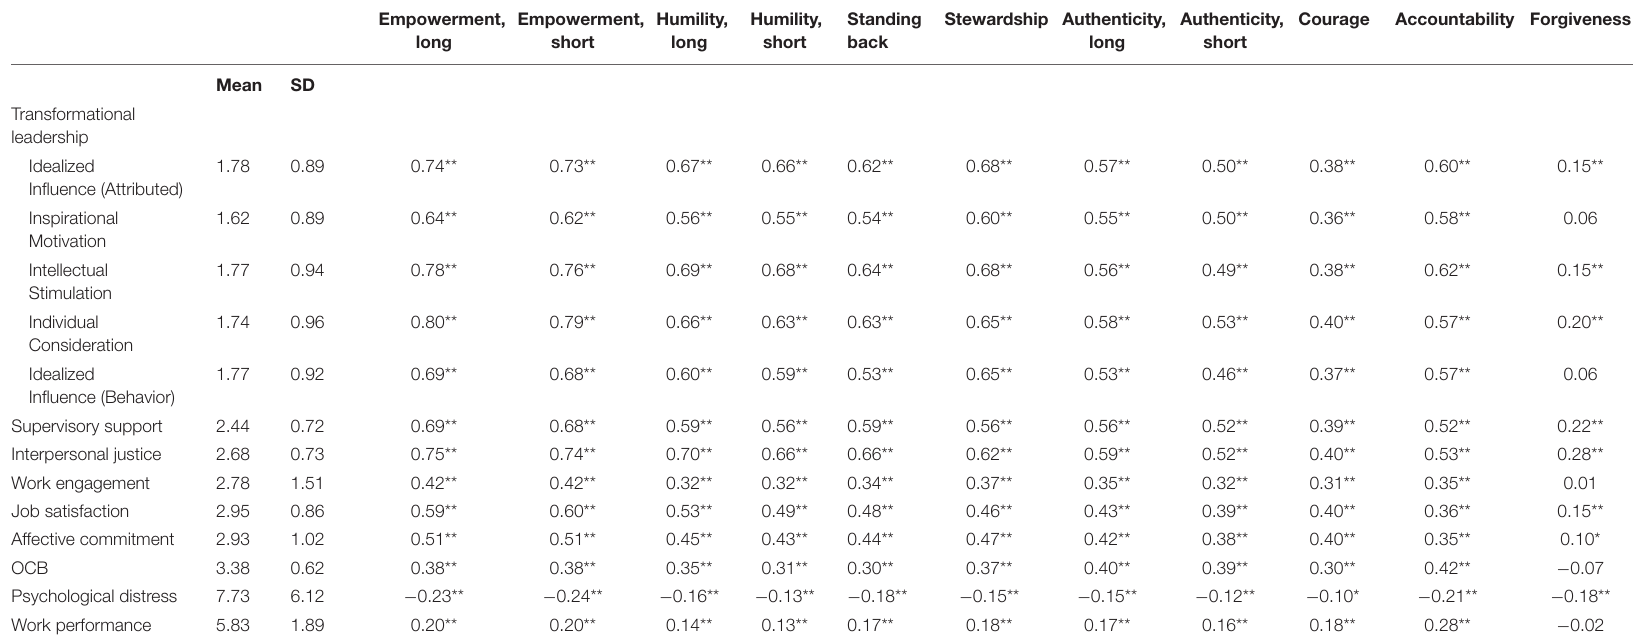
TABLE 6 | Convergent validity (r) of SLS-J and SLS-J-short dimensions ( N =